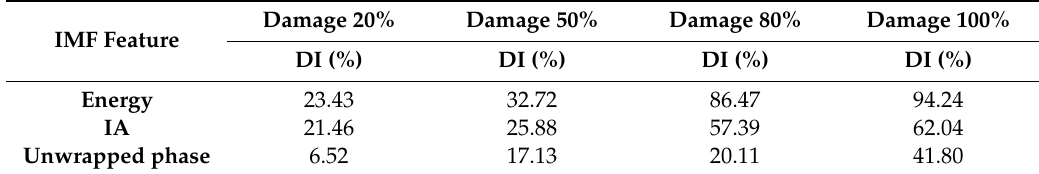
Table 1. Damage index (DI) results based on the energy, instantaneous amplitude (IA), and unwrapped phase of IMFs for the di ff erent damage levels.